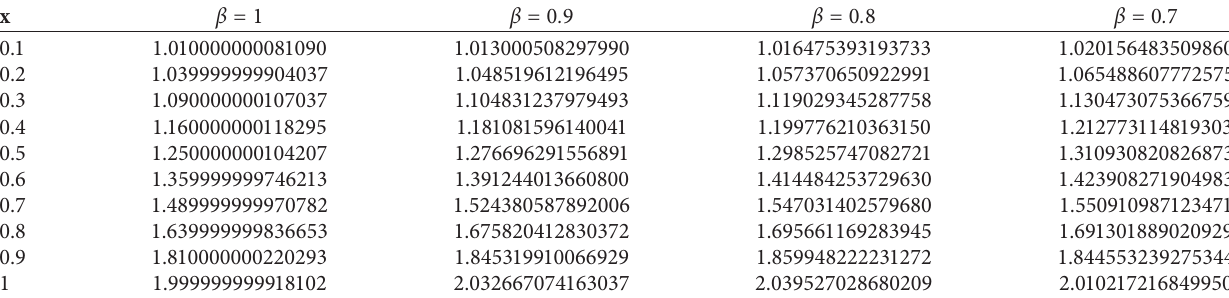
Table 4: The results are obtained for different fractional orders and N � 130.